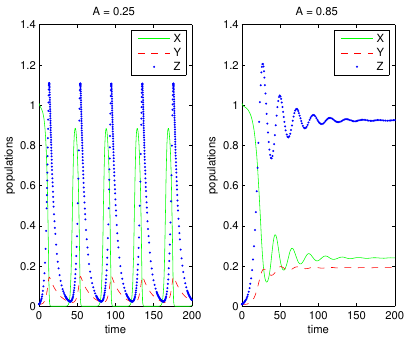
Figure 3. Parameter values: r = 0 . 95, c = 0 . 066, w = 0 . 083, s = 0 . 075, v = 0 . 8, d = 0 . 15, B = 0 . 84: left A = 0 . 25; right A = 0 . 85.